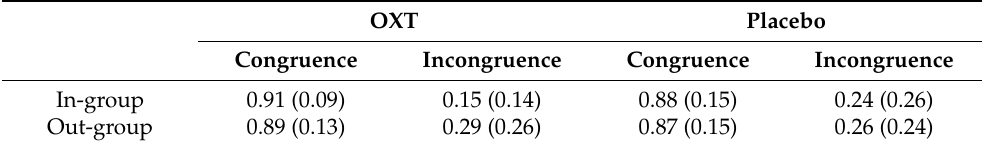
Figure 3. The mean social comparative indices across conditions. Error bars represent the standard errors of the mean for each condition. OXT enhanced differences in the social comparative index between the in-group and out-group conditions only in the incongruence condition (* p < 0.05). Table 1. Mean (SD) social comparative indices for each